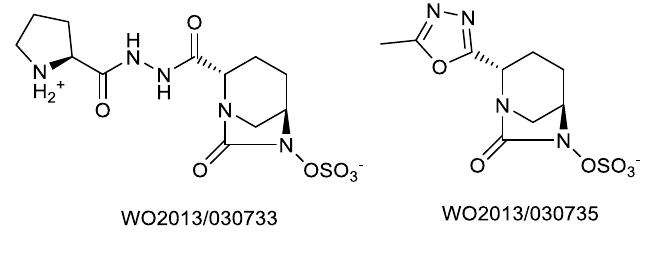
Figure 17. Chemical structure of antibacterial diazabicyclooctanes.